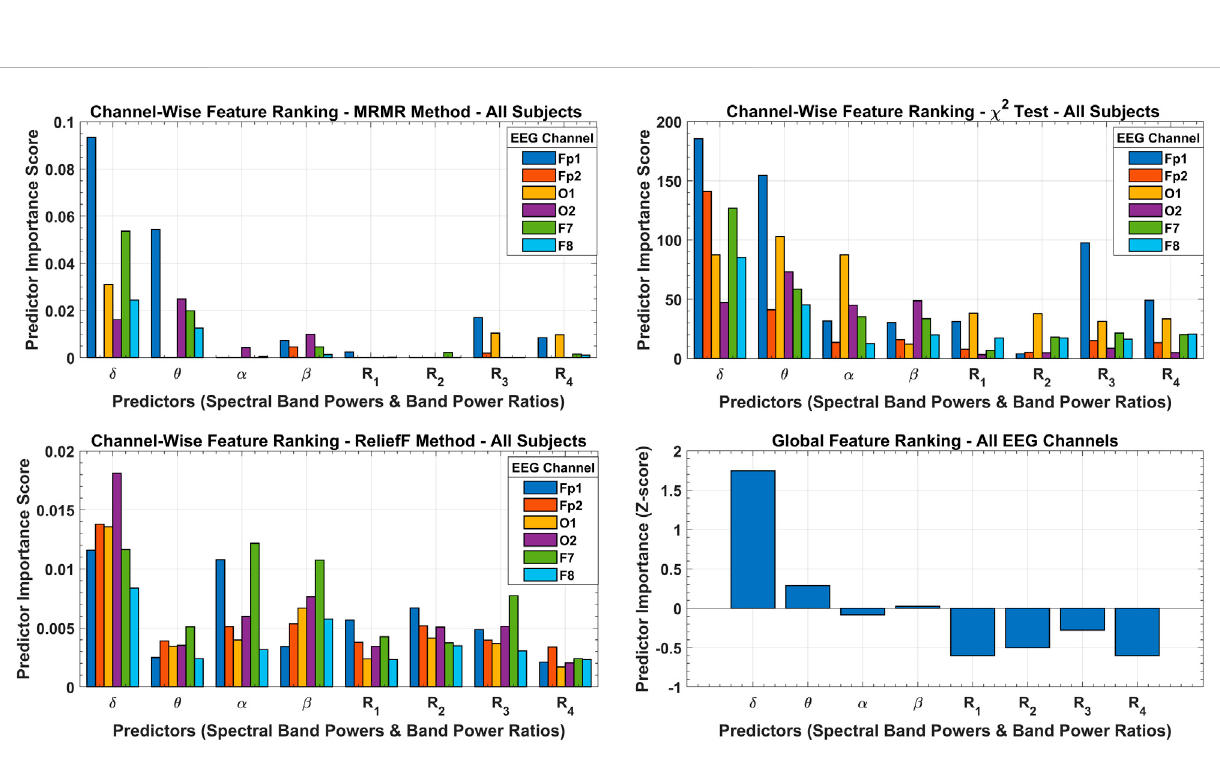
FIGURE 8 Channel-wisefeaturerankingwithMRMR,chi-square,andReliefFmethodswithpredictorimportancescoresoverallsubjects ’ data.Thecumulative effect of all feature selection methods is shown with a global feature ranking scheme with predictor importance in terms of Z